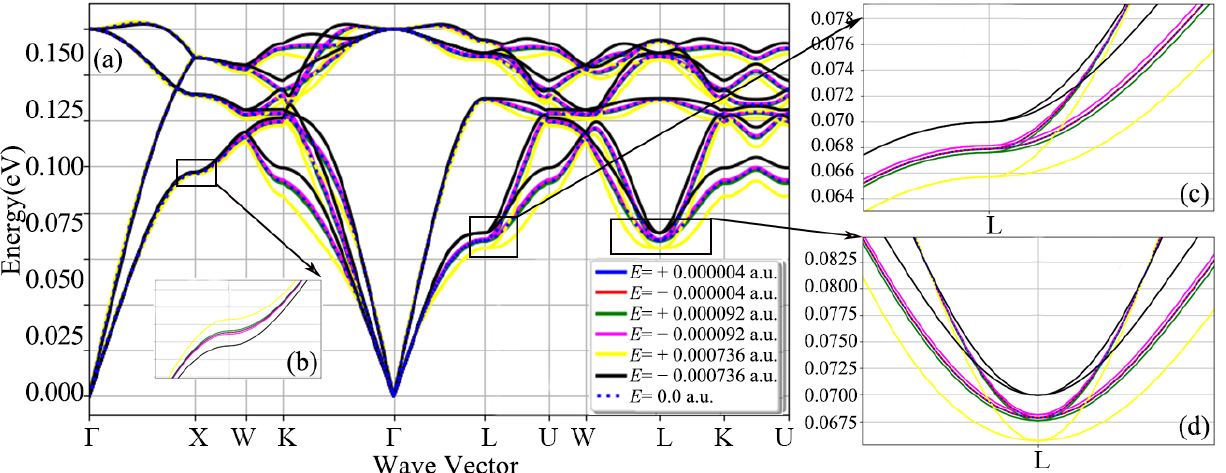
Figure 4. Phonon spectra of diamond primitive cells with fixed lattice structure and atomic positions after applying different electric fields in the [110] crystallographic direction: ( a ) full phonon dispersion diagram along a high symmetry path, ( b – d ) are the phonon dispersion relation curves at point X, point L, and point L, respectively.